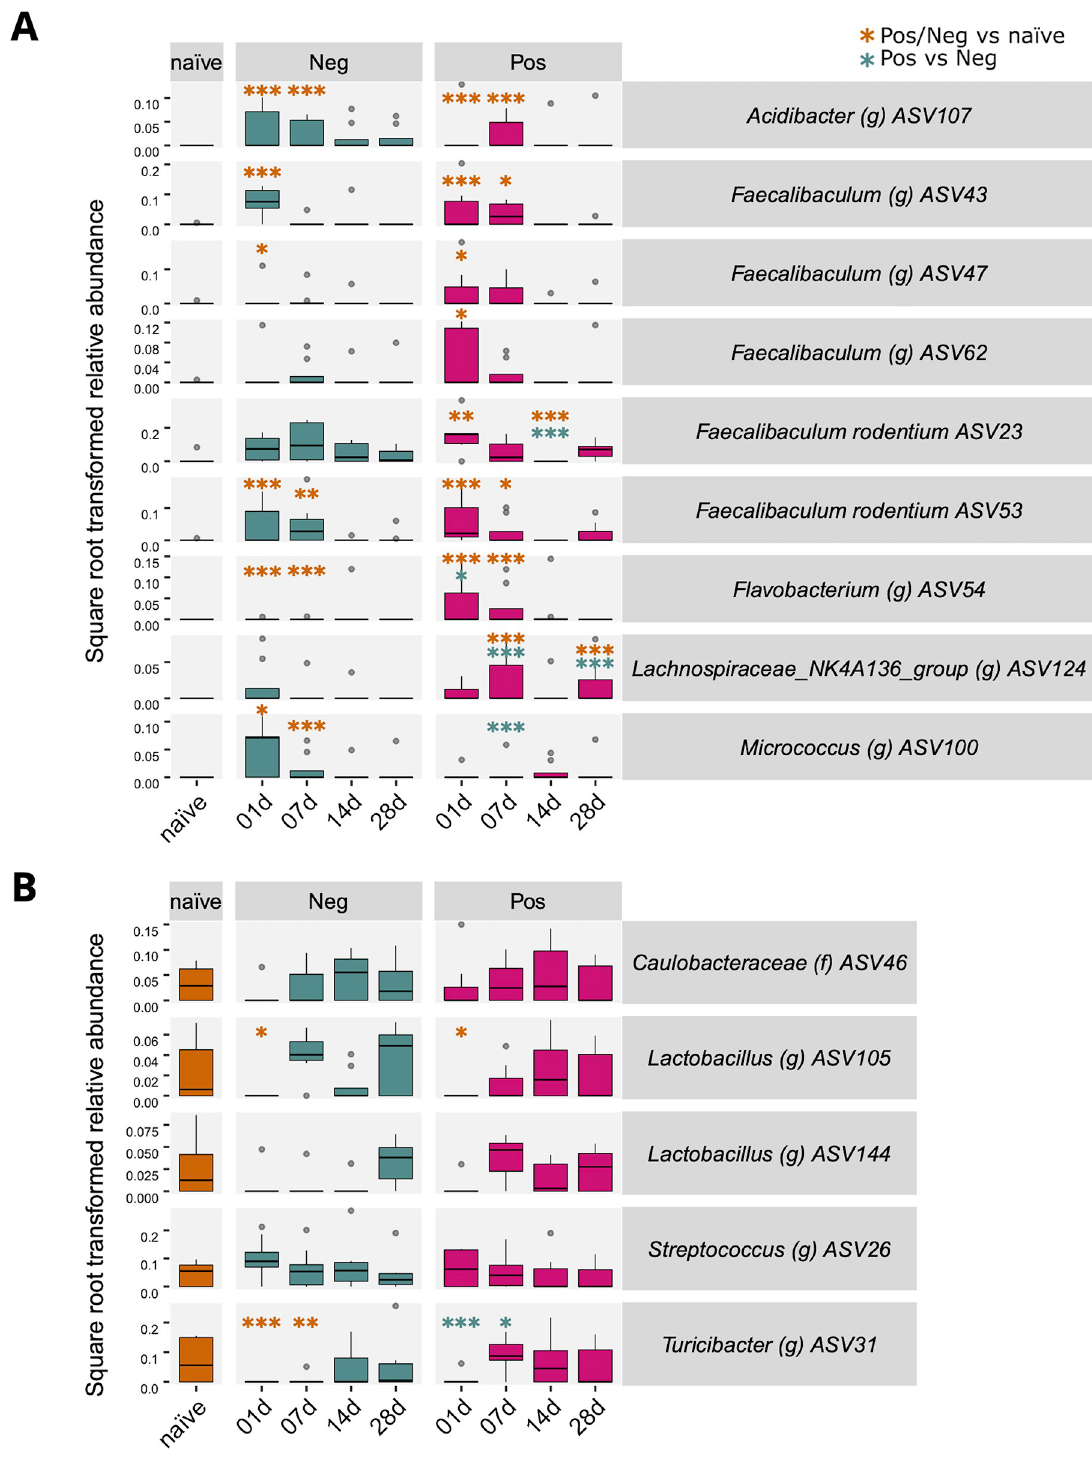
Fig 3. Microbial abundance in different groups and timepoints based on variance partition analysis. Hierarchical Modelling of Species Communities (HMSC) model was utilised for the most abundant ASVs (n = 100) to examine changes of ASV abundance between groups and timepoints. ASV abundances were included as a response variable, while the interaction of group and timepoint in addition to library size were included as explanatory variables to model the communities. Each mouse and cage were included as random effects. The ASVs with the most variance originating from the interaction of positive group and timepoint (A) and of negative group and timepoint